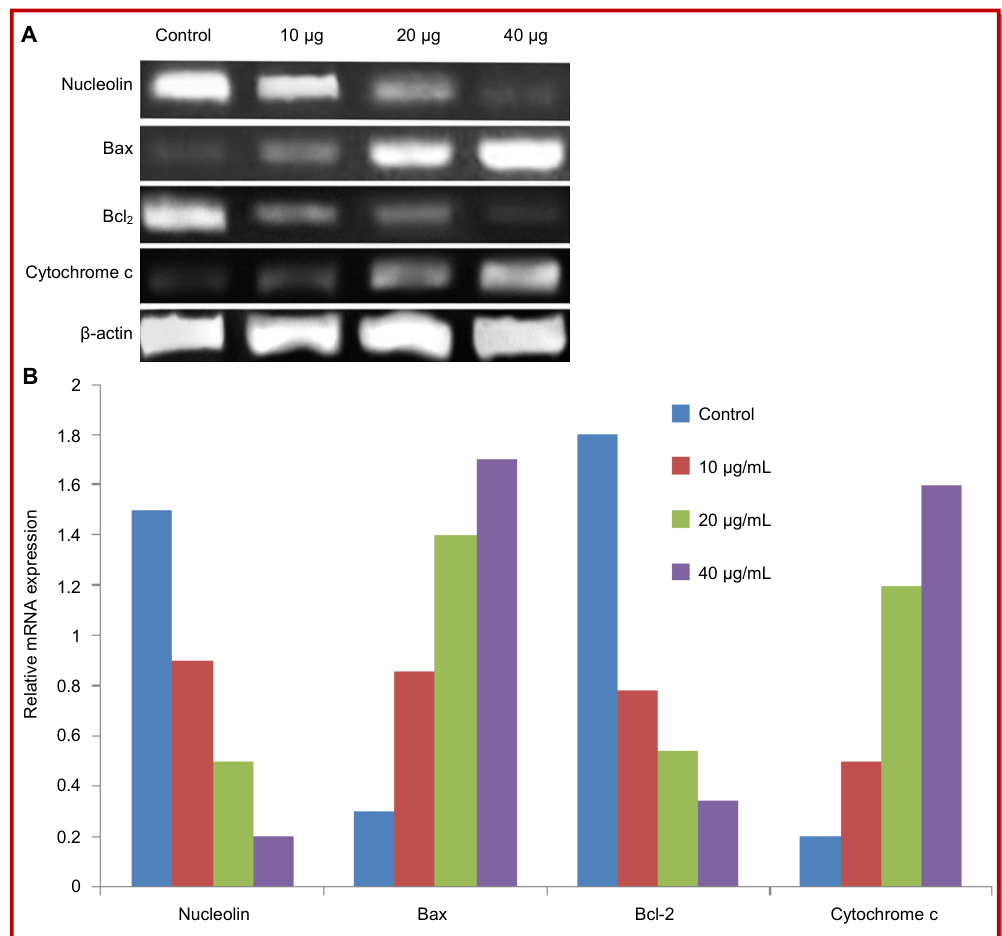
Figure 3 : Expression level of nucleolin, bcl 2 , cytochrome c and bax in MCF-7 cell extract treated with different concentration of ethyl acetate extract of O. stamineus (A); Graphical representation of expression level of nucleolin, bcl 2 , cytochrome c and bax was determined by RT-PCR in MCF-7 cell extract